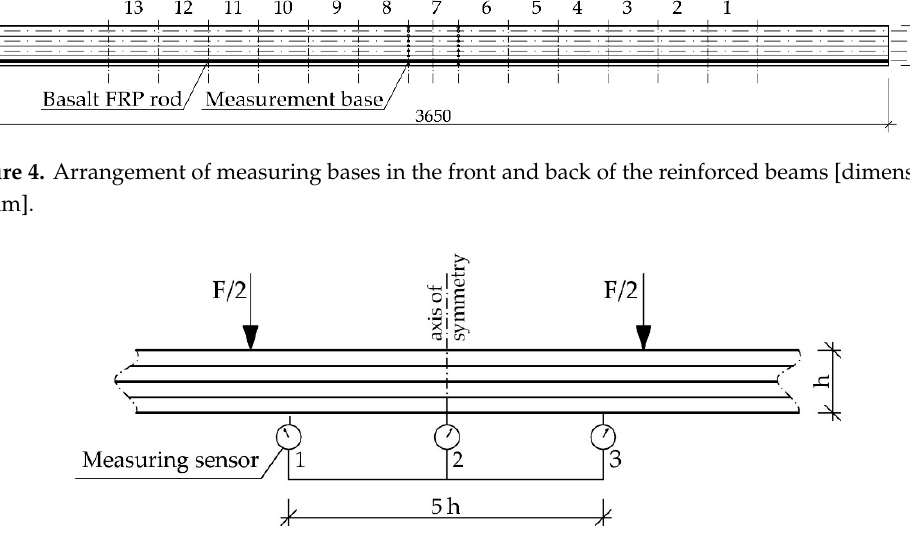
Figure 5. Arrangement of measuring sensors.